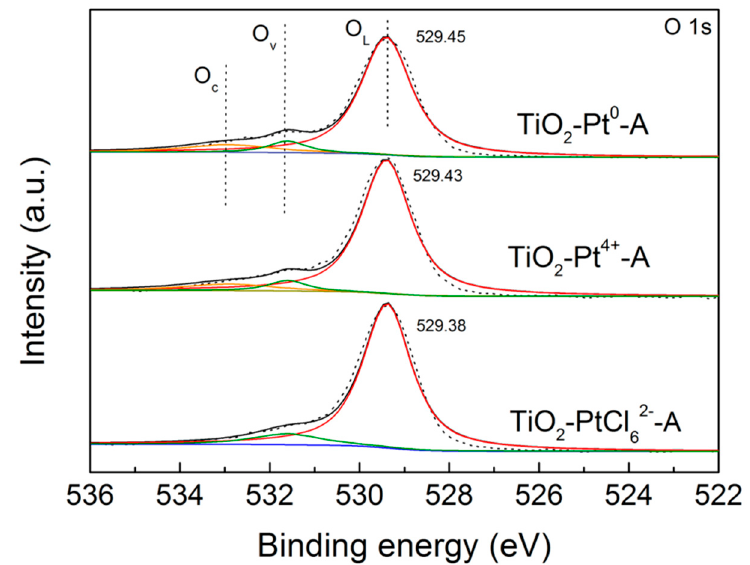
Figure 5. O 1s XPS spectra of the used Pt/TiO 2 samples via three different Pt sources.